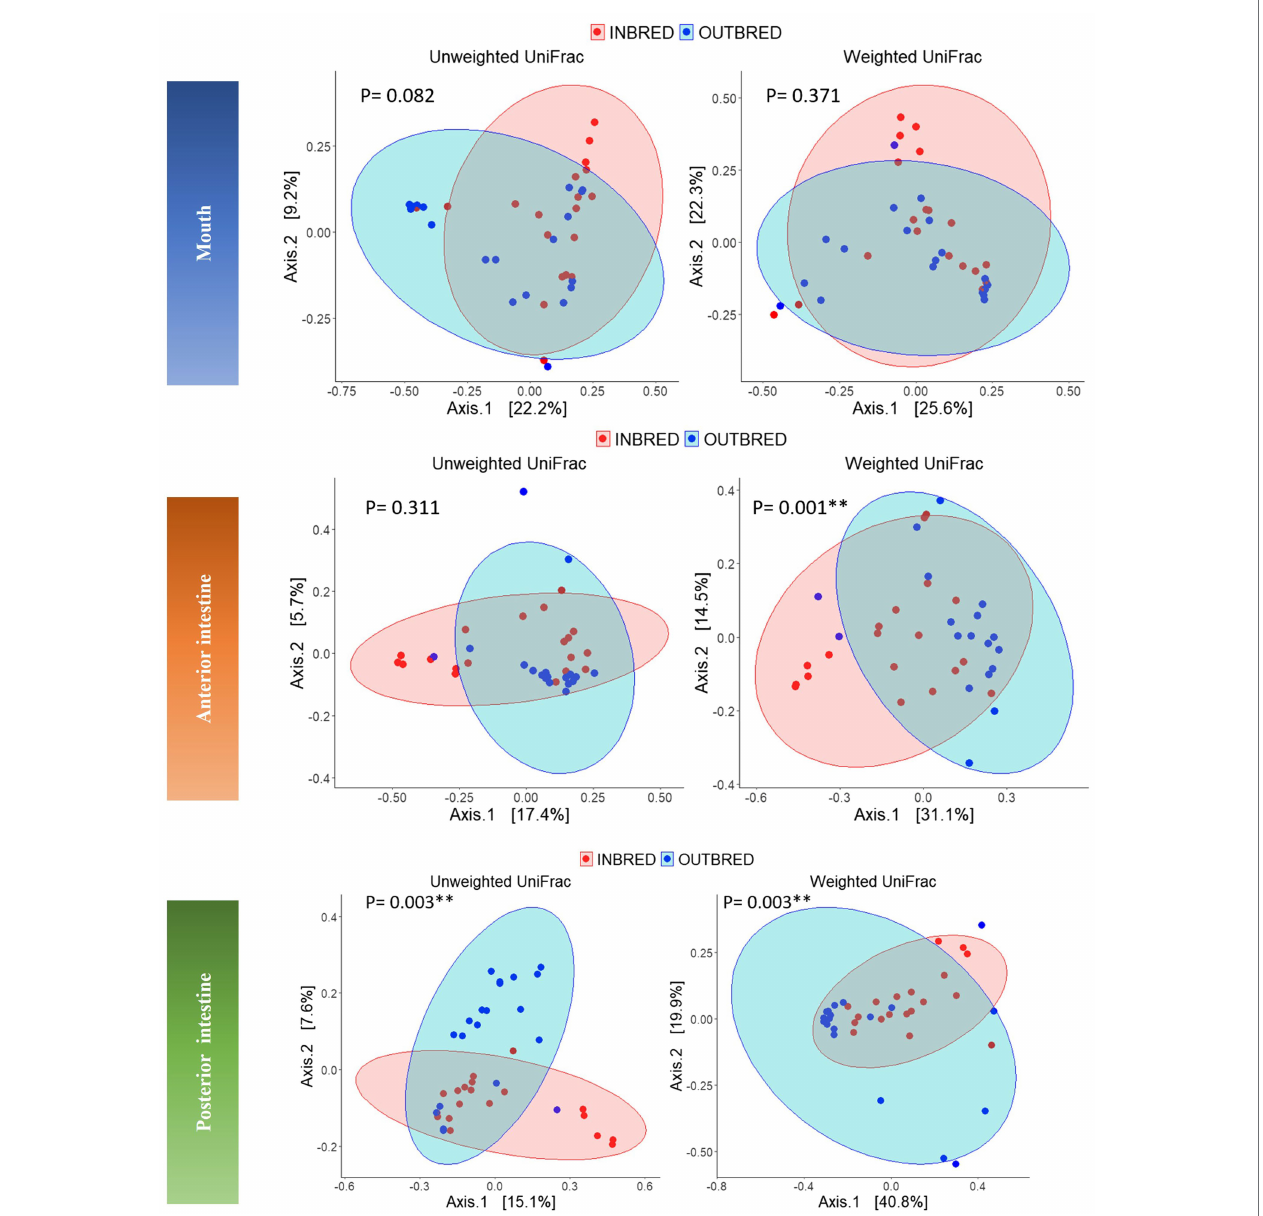
FIGURE 5 | Principal coordinates analyses (PCoA) using unweighted and weighted UniFrac distance matrices of the bacteria in the different body sites of the inbred and outbred groups of Nile tilapia. The ellipses were generated assuming that the data are from a multivariate normal